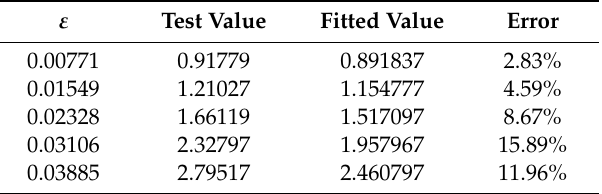
Table 8. The deviation between the tested stress and the fitted stress for specimen 1 under 500 ◦ C.